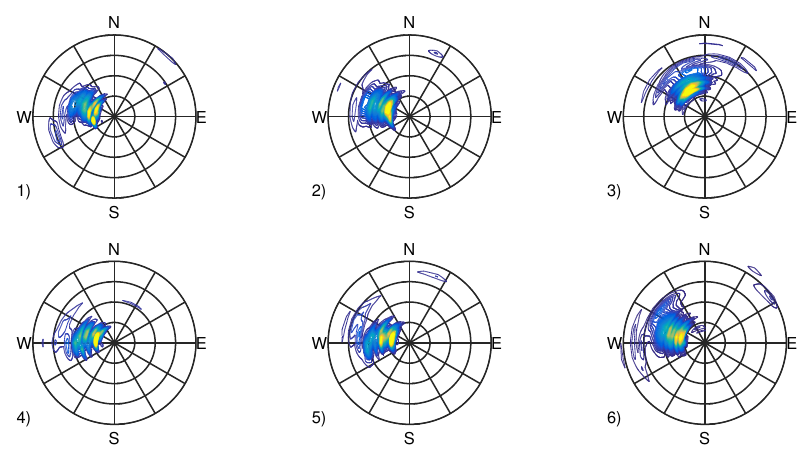
Figure 8. Directional spectra for identified extreme sea states, scaled to desired extreme conditions. 1 ) to 6 ) correspond to sea states 1 to 6 defined in Table